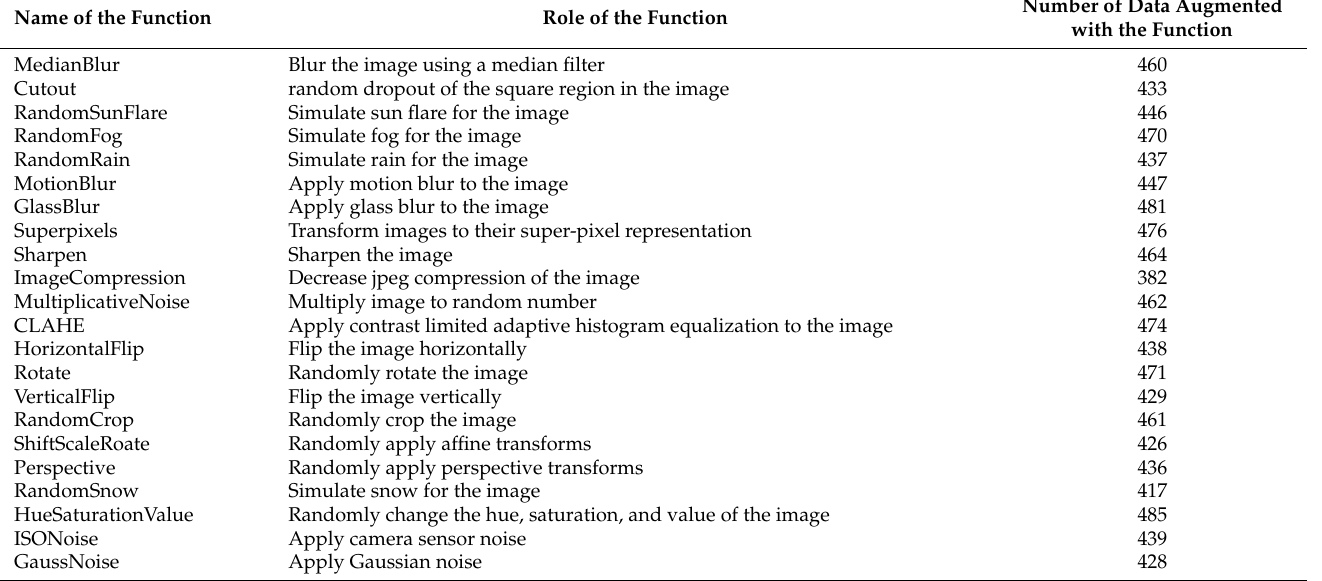
Table 1. Functions used for training data augmentation of Faster RCNN